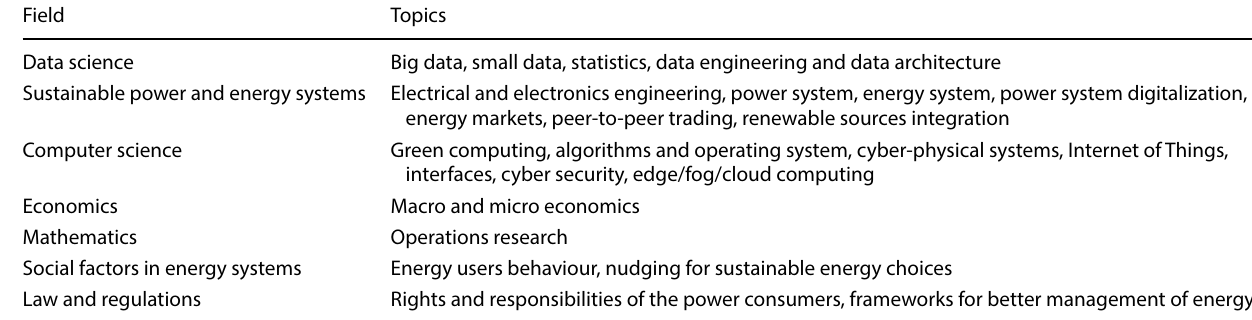
Table 1 Research